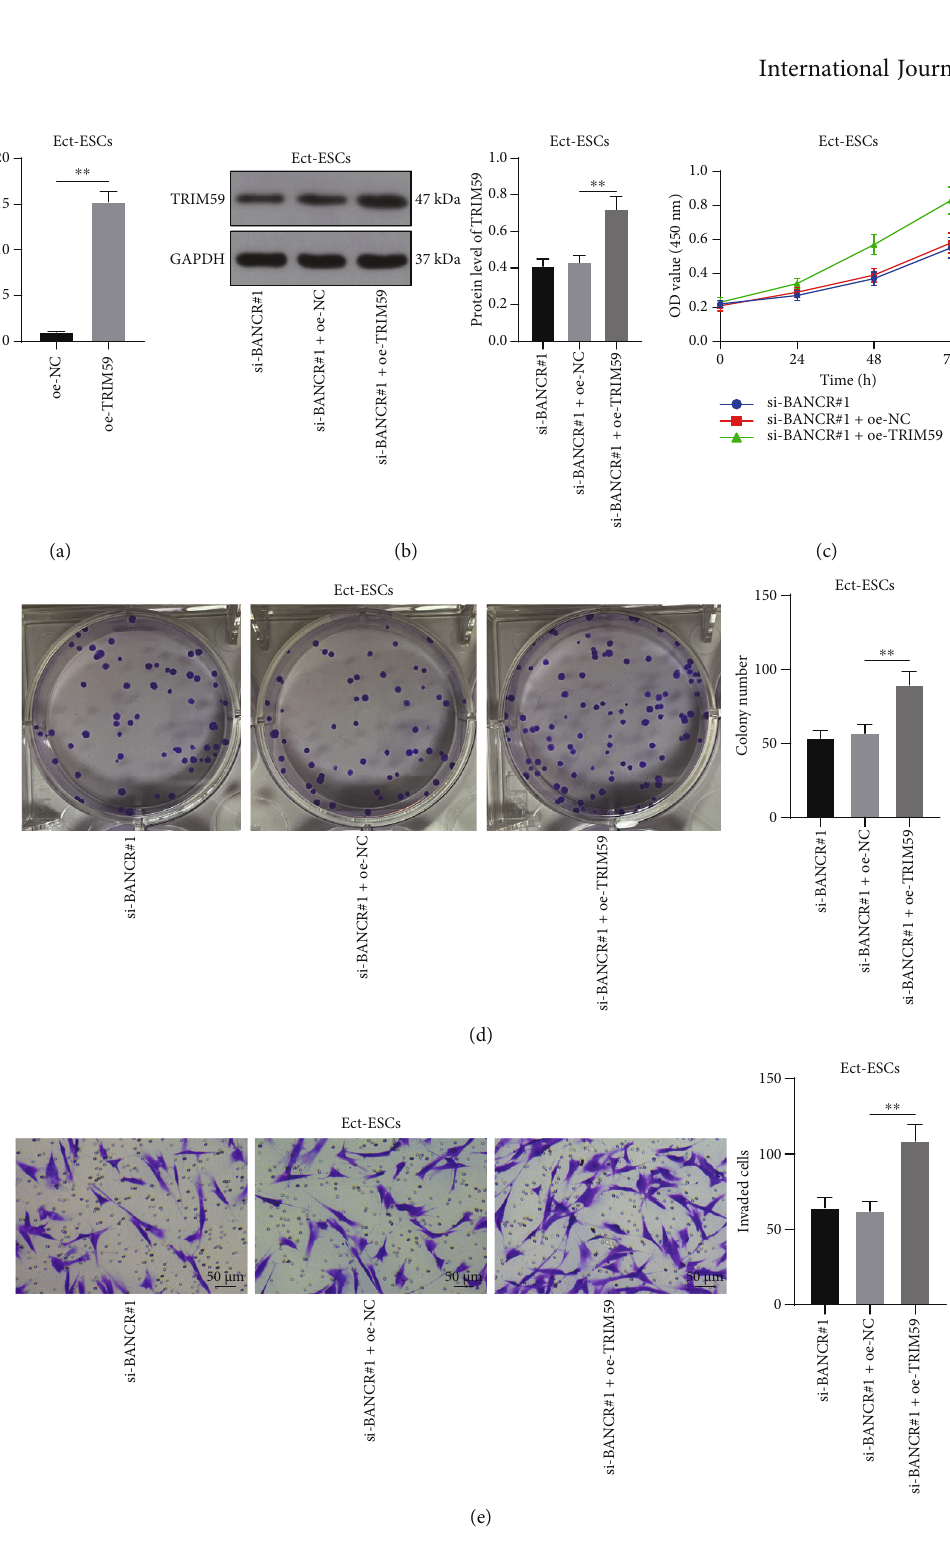
Figure 5: TRIM59 overexpression reverses the e ff ects of silencing lncRNA BANCR on inhibiting ectopic endometrial stromal cell proliferation and invasion. Ect-ESCs were transfected with oe-TRIM59, with transfection of oe-NC as the negative control. (a) – (b) Expression levels of TRIM59 were determined by RT-qPCR (a) and Western blot assay (b); (c) – (d) Proliferation potential of Ect-ESCs was assessed by CCK-8 (c) and colony formation (d) assays; (e) Invasion potential of Ect-ESCs was assessed by transwell assay. Cell experiments were performed thrice independently. Data in fi gures (a) – (e) were formalized as mean ± SD. Data in fi gure (a) were analyzed using the t test, data in fi gures (b), (d), and (e) were analyzed using one-way ANOVA, and data in fi gure (c) were analyzed using two-way ANOVA, followed by Tukey ’ s multiple comparison test. ** P < 0 : 01